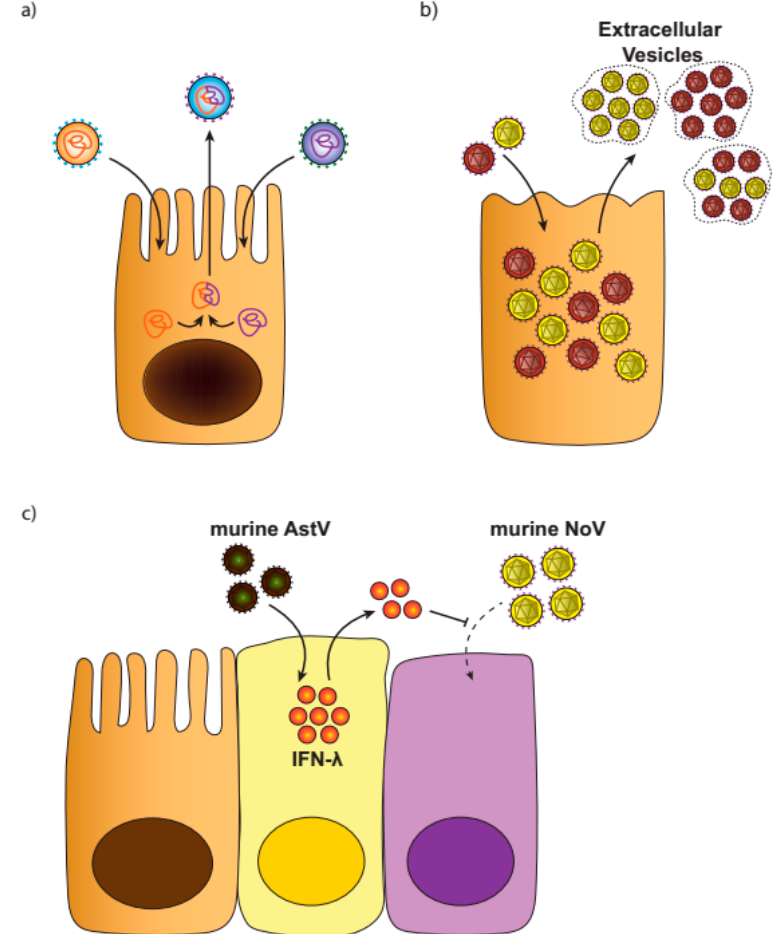
Figure 1. Potential consequences of enteric viral co-infections. ( a ) Co-infection of multiple viral strains in a single cell facilitates the recombination and generation of novel strains. ( b ) Extracellular vesicles containing multiple virions of a single virus type, one means of co-infecting new cells. Whether co-infection with unrelated viruses could lead to co-packaging is unknown. ( c ) An example of enteric viral interference, wherein murine AstV infection inhibits murine NoV infection of tuft cells via IFN- λ production.